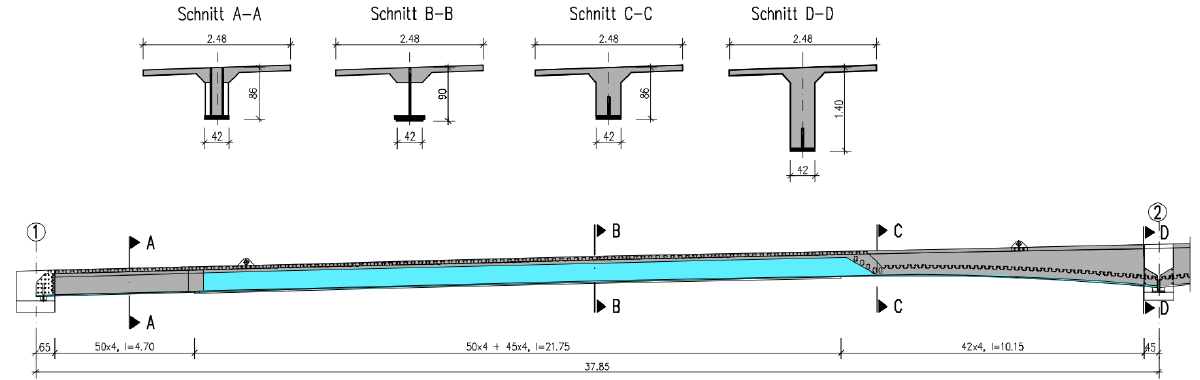
Figure 4: External span of the Elbląg bridge [4, 5].